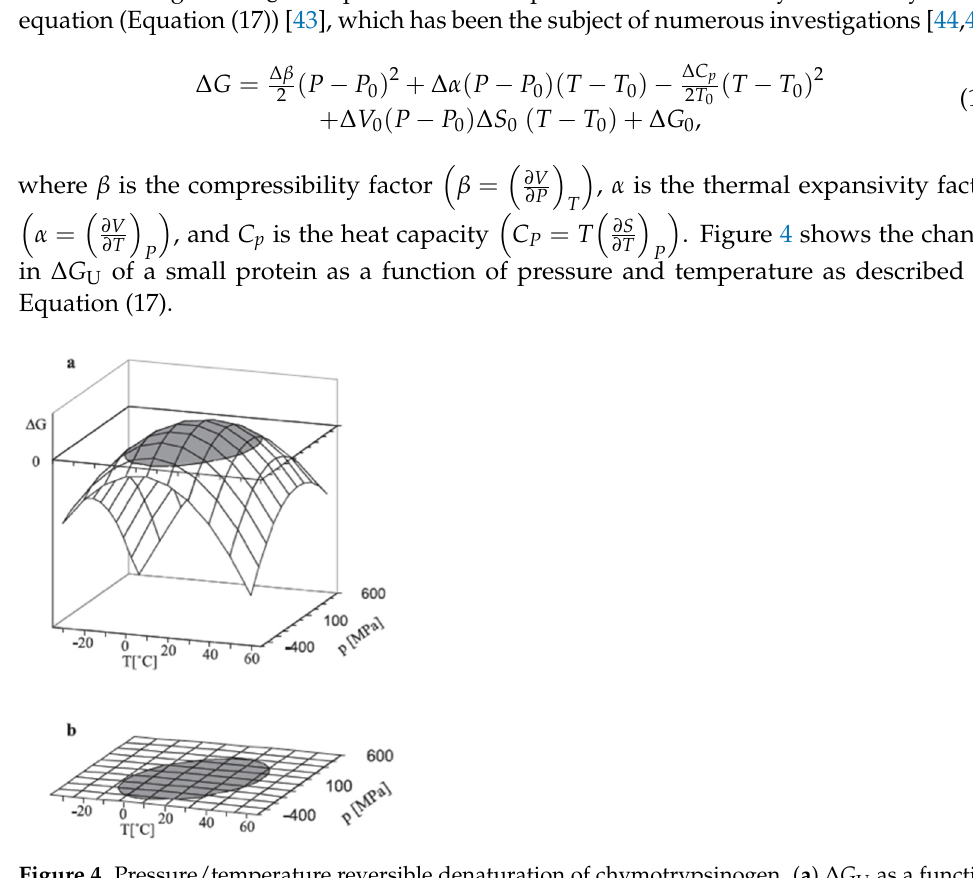
Figure 4. Pressure/temperature reversible denaturation of chymotrypsinogen. ( a ) ∆ G U as a function of temperature and pressure; ( b ) elliptical phase diagram as the horizontal projection of ∆ G U = f ( P , T ) for ∆ G U = 1, the grey area shows the region where the native protein is more stable (reproduced from [44] with permission from Elsevier).